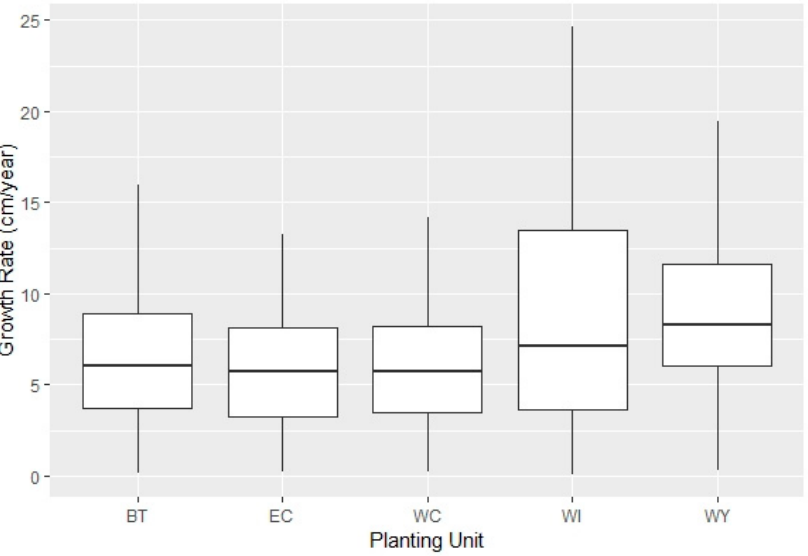
Figure 4. Adjusted growth rates (cm year − 1 ) across units (BT = Beartooth, EC = East Centennial, WC = West Centennial, WI = Wind River, WY = West Yellowstone).